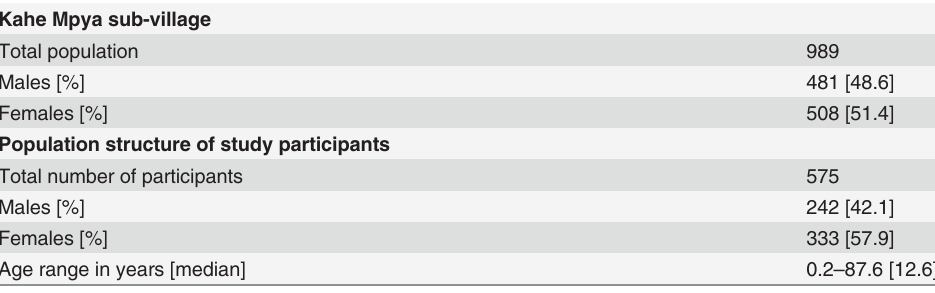
Table 1. Population structure of Kahe-Mpya and the study population.